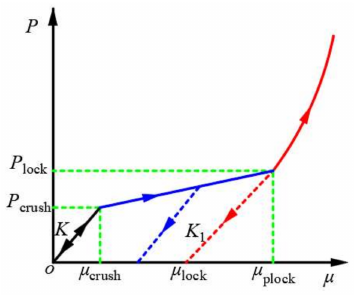
Figure 5. Relationship between P and µ